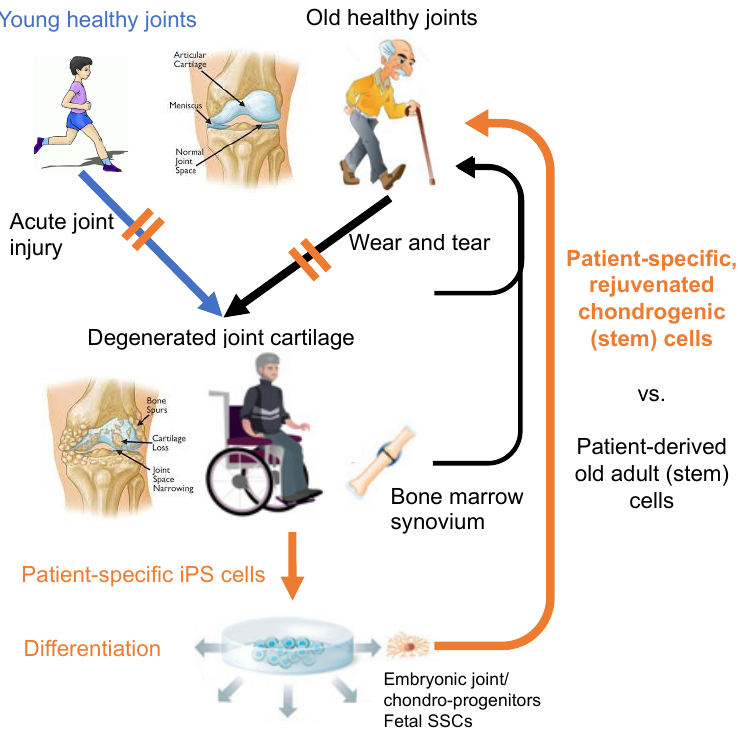
Figure 3. In total, two sources of patient-specific cells for regeneration of injured and degenerated cartilage: adult cells vs. rejuvenated (i.e., iPSC-derived) cells. Does rejuvenation make difference in the outcome of joint cartilage repair? The joint illustrations are in courtesy of OrthoInfo © American Academy of Orthopaedic Surgeons. Other illustrations were purchased from